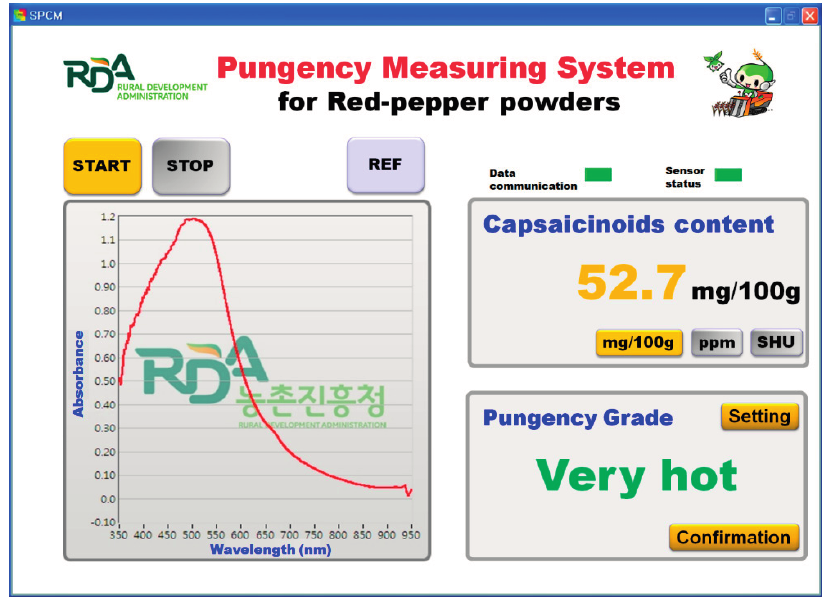
Figure 8. A screen shot of the graphical user interface for the measurement system for the capsaicinoid content of red pepper